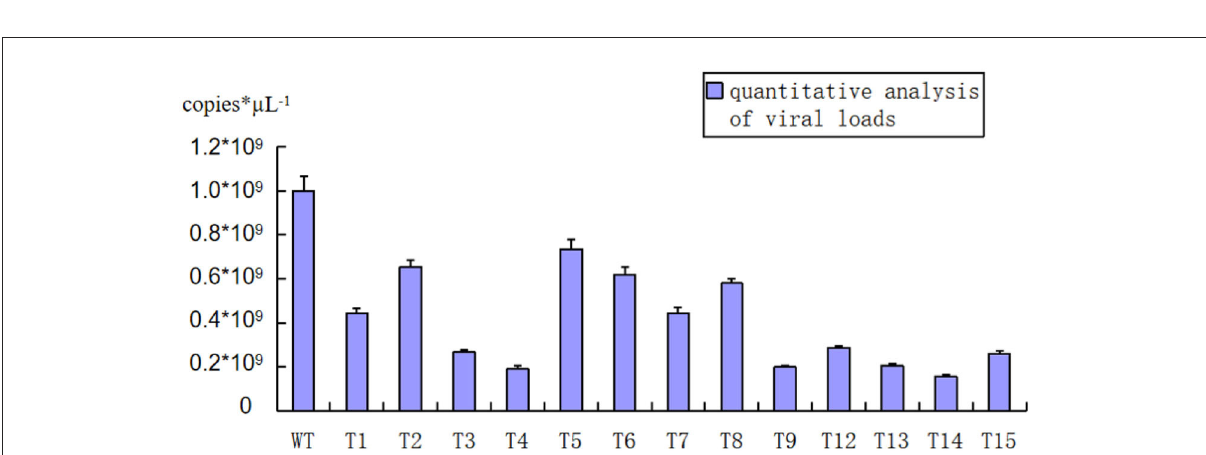
FIGURE8 RT-qPCR testing of SCSMV viral loads for each transgenic and wild-type shoot (Three months after transplant in green house). WT, wild-type shoots showed higher SCSMV viral loads than transgenic shoots; T1-T15, transgenic shoots showed lower SCSMV viral loads than wild-type shoots